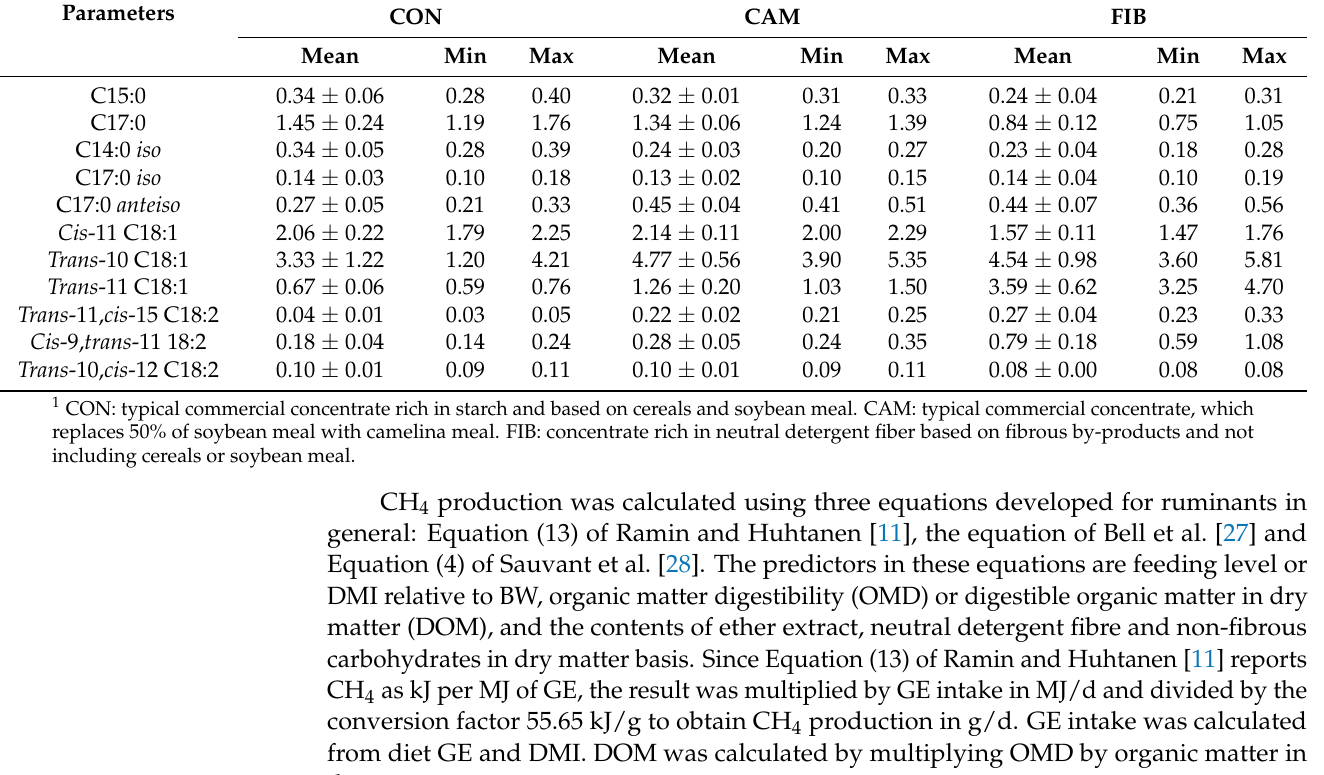
1 CON: typical commercial concentrate rich in starch and based on cereals and soybean meal. CAM: typical commercial concentrate, which replaces 50% of soybean meal with camelina meal. FIB: concentrate rich in